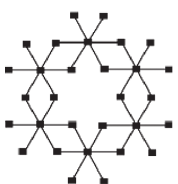
Figure 18: Comparison of the second Gourava index.